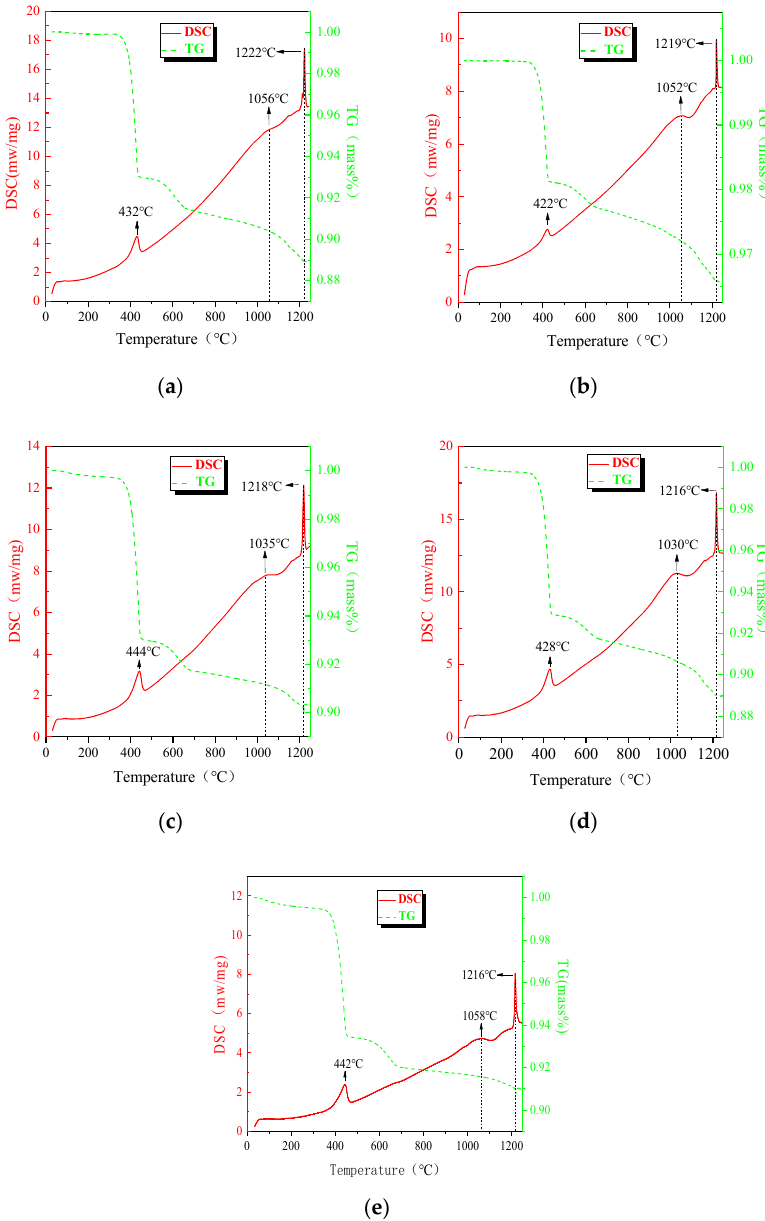
Figure 1. Curves of the mixed powders with different Al 2 O 3 contents. ( a ) 0, ( b ) 1.4%, ( c ) 2.8%, ( d ) 4.2%, ( e ) 5.6%.